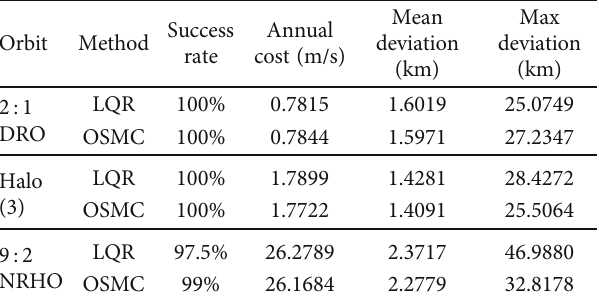
Figure 11: The station-keeping simulations of the 9:2 NRHO under practical constraints. Table 4: The performance indexes of the station-keeping simulations with both strategies for main nominal